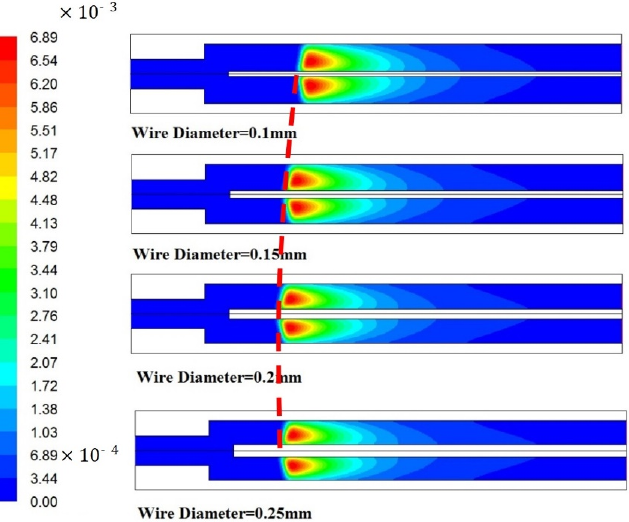
Figure 2. The studied computational mesh; temperature distribution on the auxiliary axis of r = 0.3 mm.